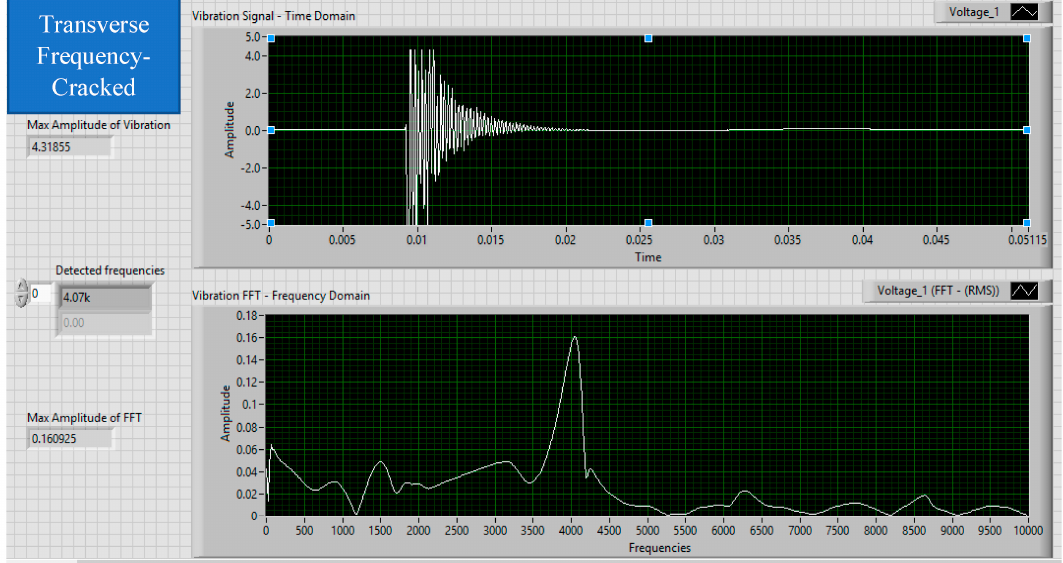
Figure 6. Transverse mode vibration and resonant frequency of original (uncracked) micro PFRC cylinder.